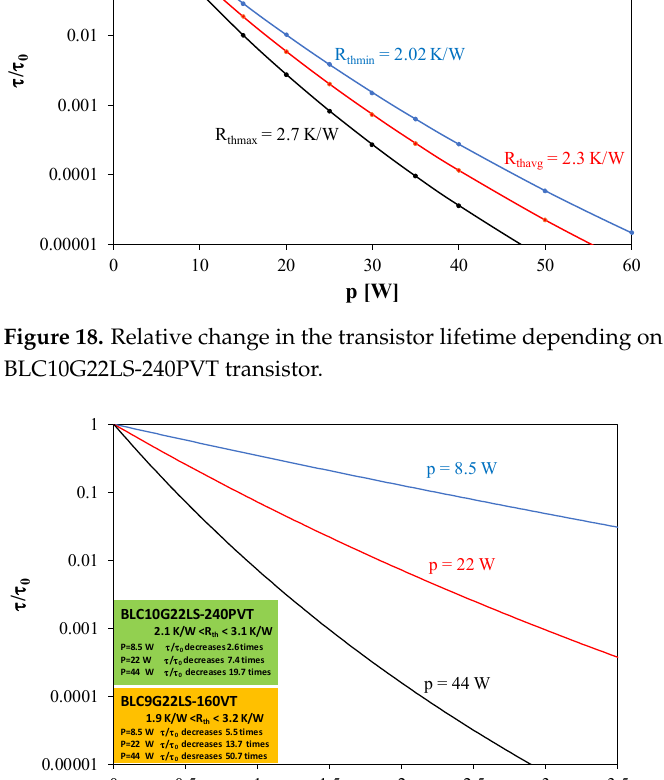
Figure 19. Relative change in the transistor lifetime as a function of thermal resistance. For the BLC10G22LS-240PVT transistor, the measured value R th under the same con-